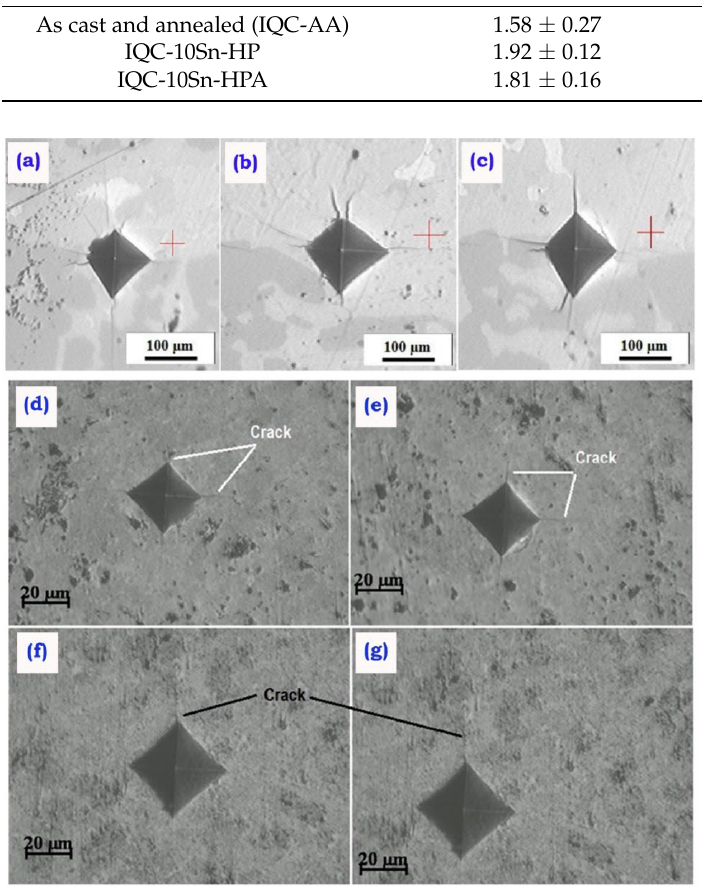
Figure 9. Optical micrograph showing indentation marks on ( a ) as-cast and annealed IQC (IQC-AA) at a load of 200 g and ( b , c ) as-cast and annealed IQC (IQC-AA) at a load 500 g. Optical micrograph showing indentation cracks in IQC-10Sn composite at a load of 500 g: ( d , e ) hot-pressed at 650 °C (923 K) (IQC-10Sn-HP) and ( f , g ) hot-pressed at 650 °C (923 K) followed by annealing at 800 °C 1023 K) (IQC-10Sn-HPA).